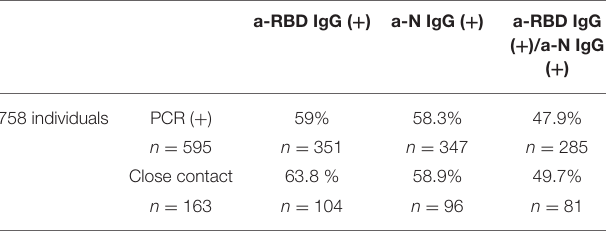
TABLE 2 | Percentages of the population studied ( n = 758), either diagnosed as SARS-CoV-2 positive by RT-PCR, or close contacts of these, that have detectable SARS-CoV-2 anti-RBD or anti-N antibodies as measured by the “ In-House ” ELISA or CMIA,